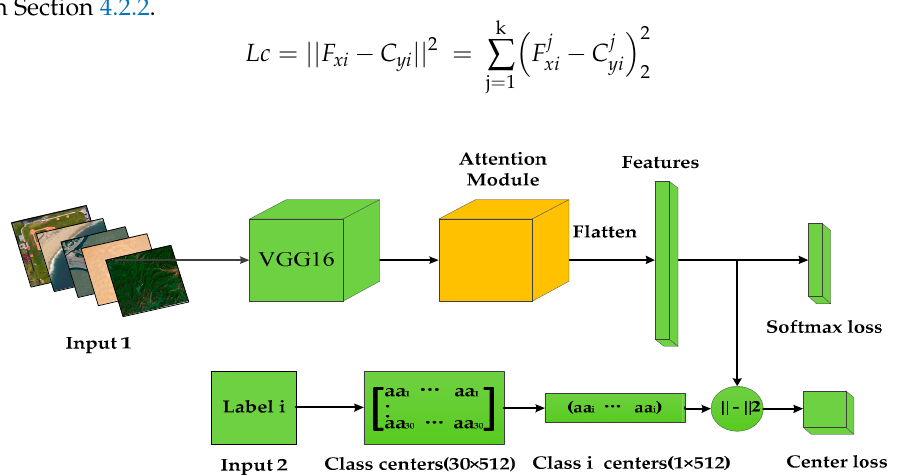
Figure 6. Diagram of the Center Loss-based multi-task learning network structure.